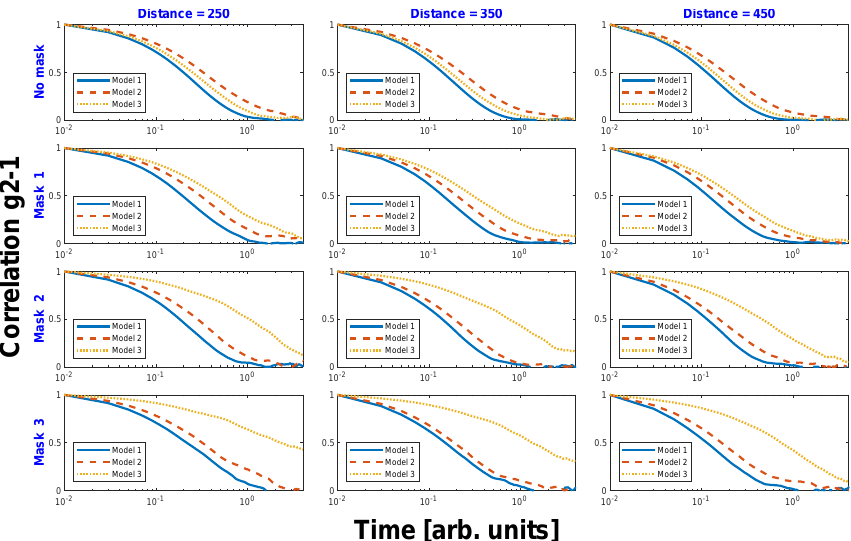
Figure 3. Equivalent representation to that of Figure 2 of the one-time correlation functions for the different models at distances 250, 350 & 450, for different masks. This representation stresses the differences in the OTCFs that are obtained for the different